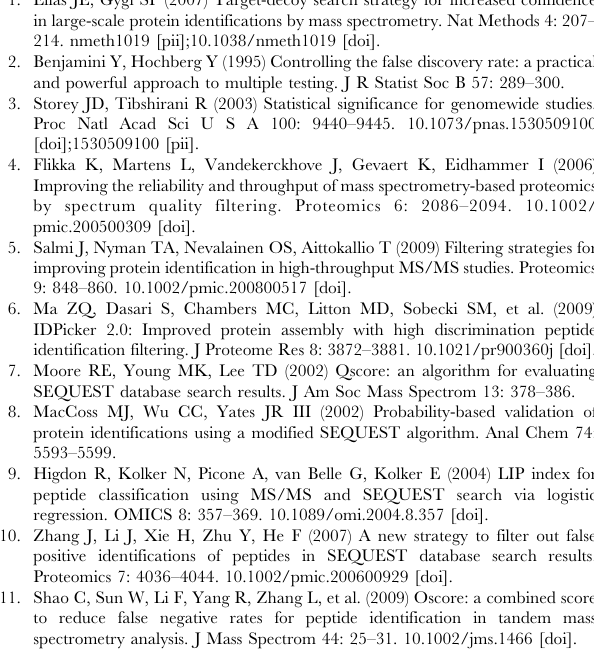
(TIF) Figure S4 Mass bias trend for X!Tandem hyperscore. Although X!Tandem values do not show mass bias, the hyperscore does show dependence on mass and thus the same trend as MassWiz. QTOF dataset is shown here as an example. (TIF) Figure S5 Mass bias trend for Mascot ion score. Mascot ion scores also show a mass bias although with negative slope. QTOF and LCQ Deca datasets have been shown as examples. (TIF) Table S1 Spectra and peptide identifications from concatenated and separate database searches for the standard mix data sets. Table S2 Spectra and peptide identifications from separate and concatenated database searches for the E. coli and Yeast data